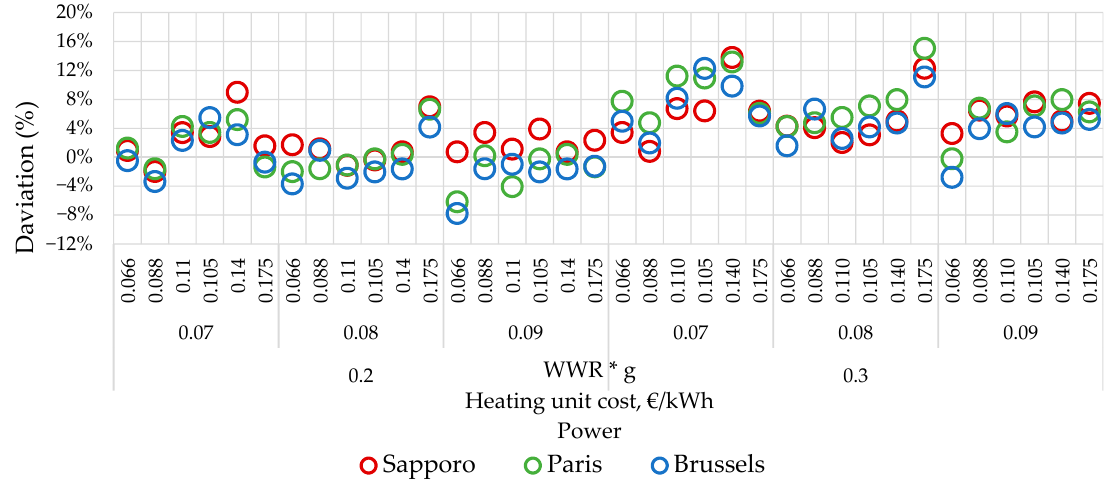
Figure 9. Deviation of normalized U-value of a single floor model for the case of fixed electricity unit cost (lowest cost-optimal solution based on investment and operational heating cost).